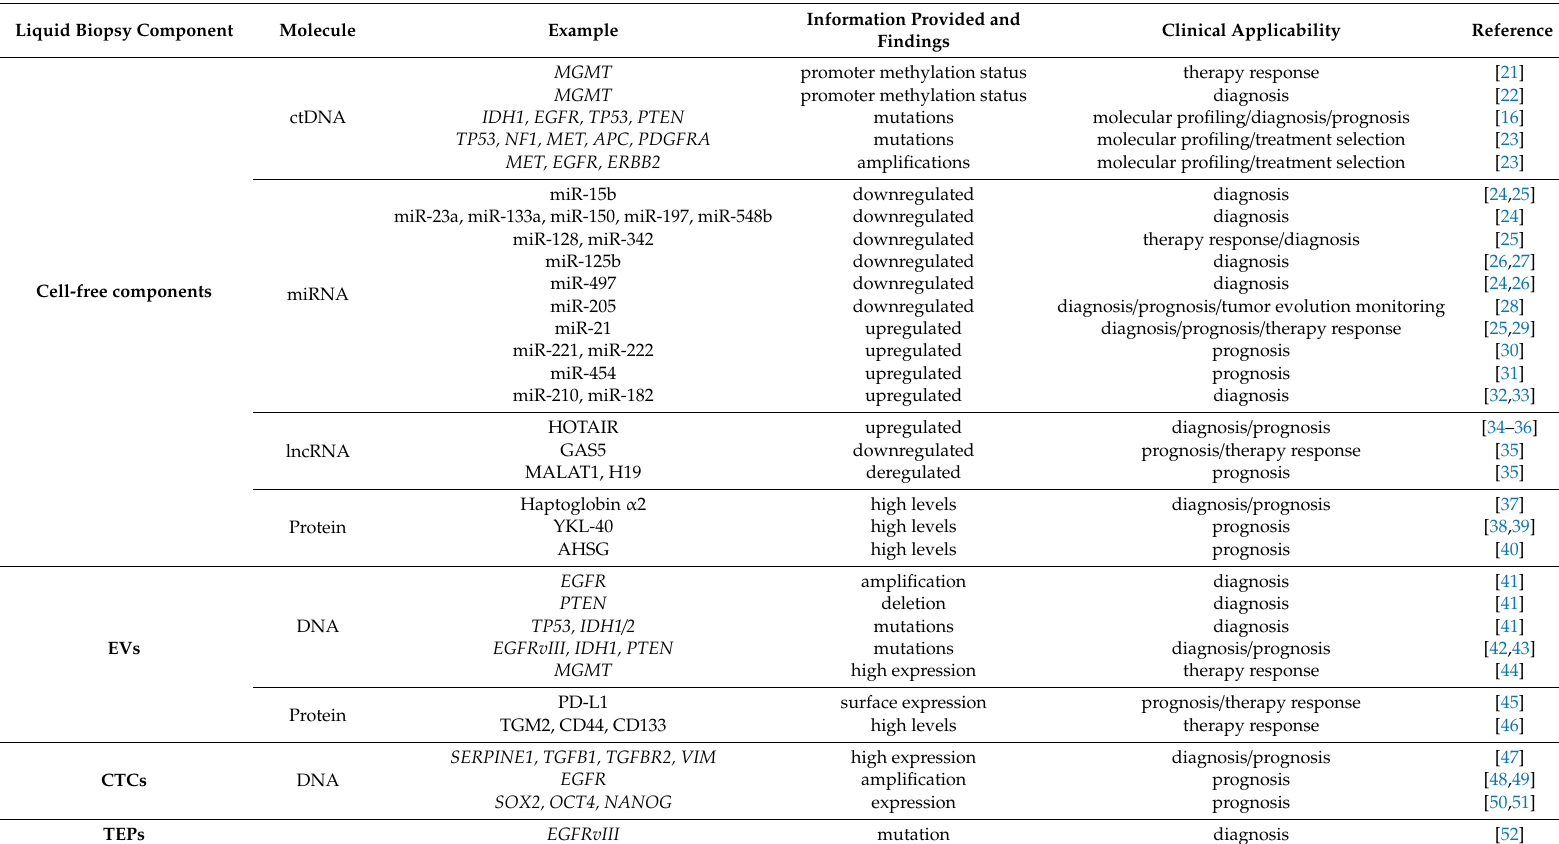
Table 1. Components identified in the blood of glioblastoma